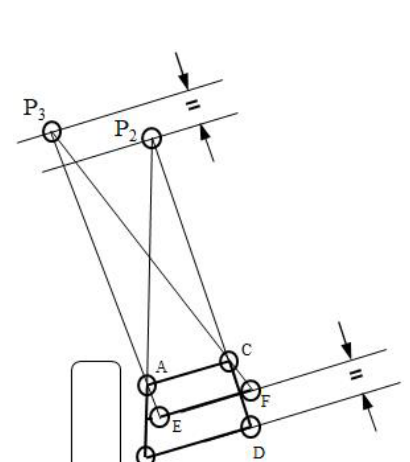
Figure 8. Process of particularization.